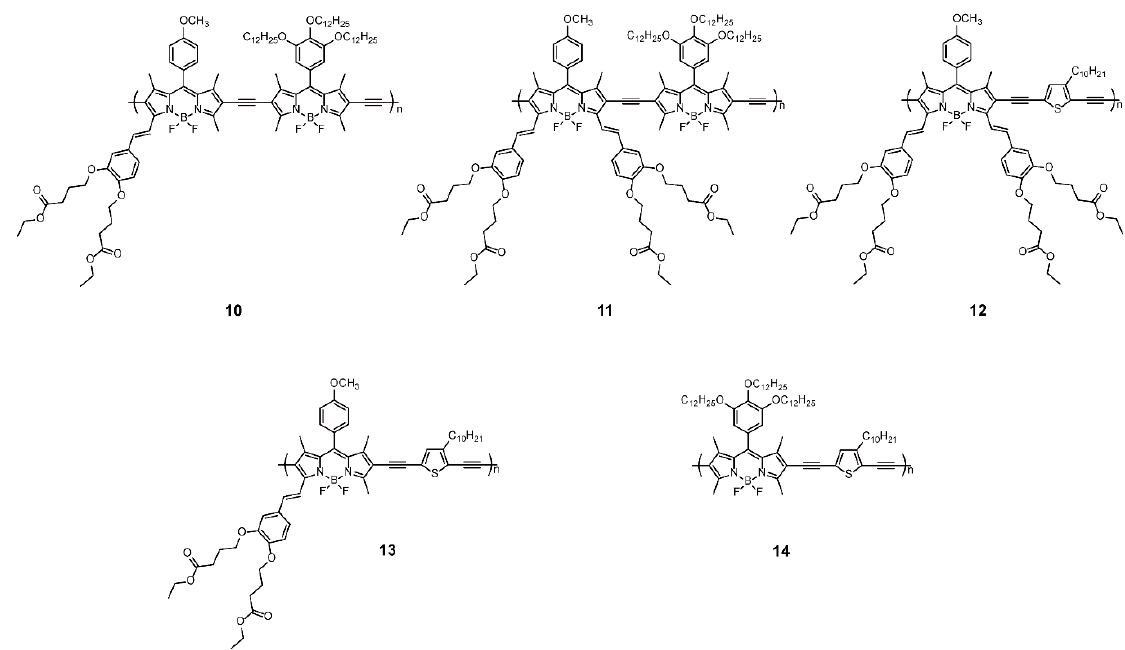
Figure 4. Chemical structures of polymers 10–14 ( Reproduced with permission from Reference [34]. Copyright @ 2012, Royal Society of Chemistry).